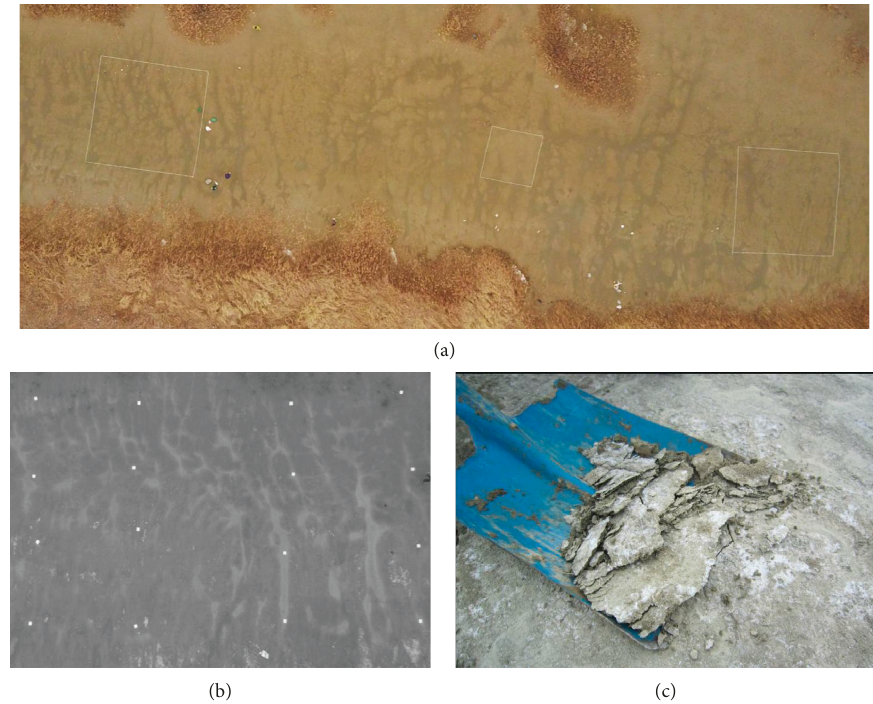
Figure 4: Soil sampling method in this study: (a) selection of sampling areas; (b) sampling location; (c) topsoil